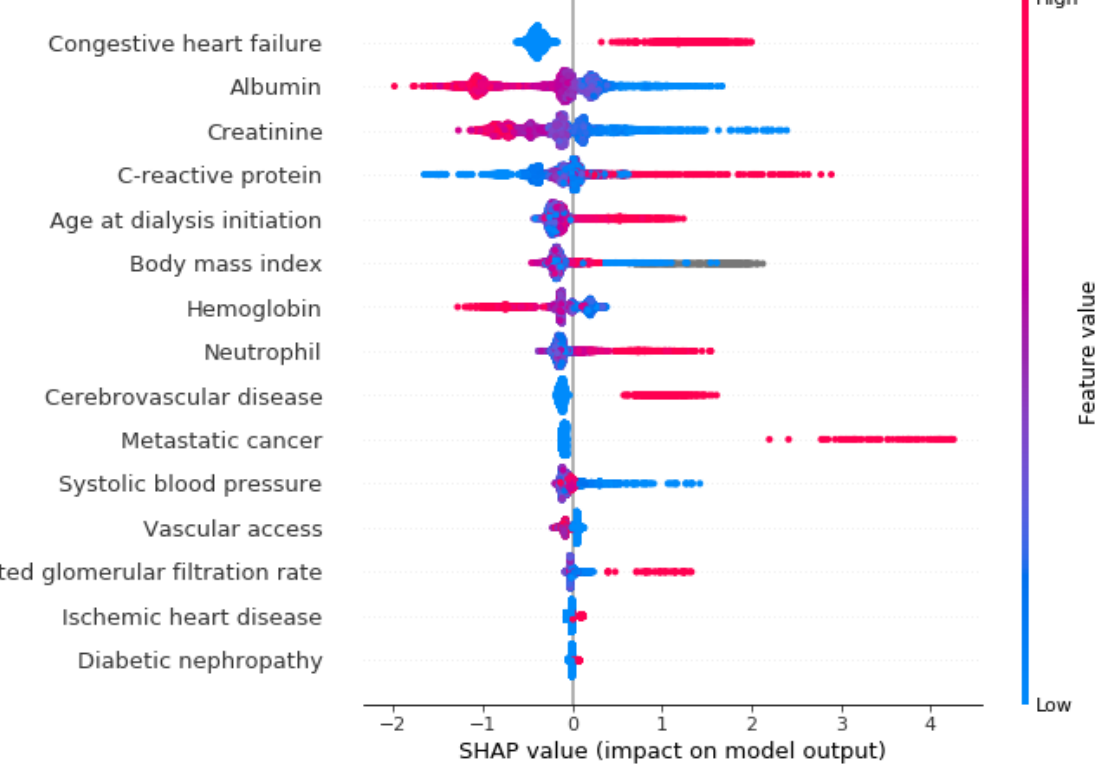
Figure 4. SHAP values illustrating how features contribute to model 2. Blue shows a negative contribution, and red shows a positive contribution. SHAP: Shapley additive explanation.